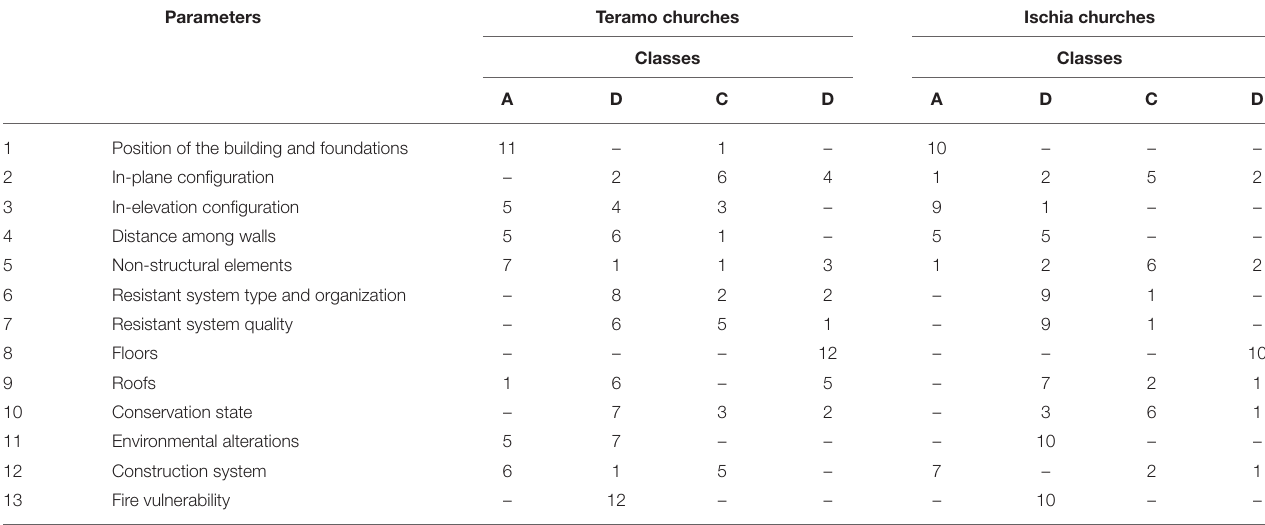
TABLE 9 | Distribution of parameter classes for Teramo